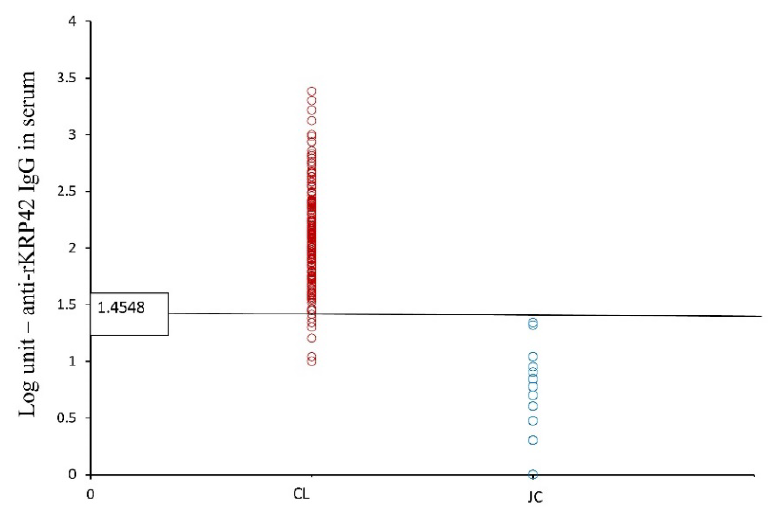
Figure 3. Anti-rKRP42 IgG titers in serum, comparison among CL and Japanese controls (JC). Urine ELISA was positive for only 61.7% of the nested PCR positives; however, the specificity remained 50%, similar to serum ELISA. PPV was high at 95.7%, but NPV was